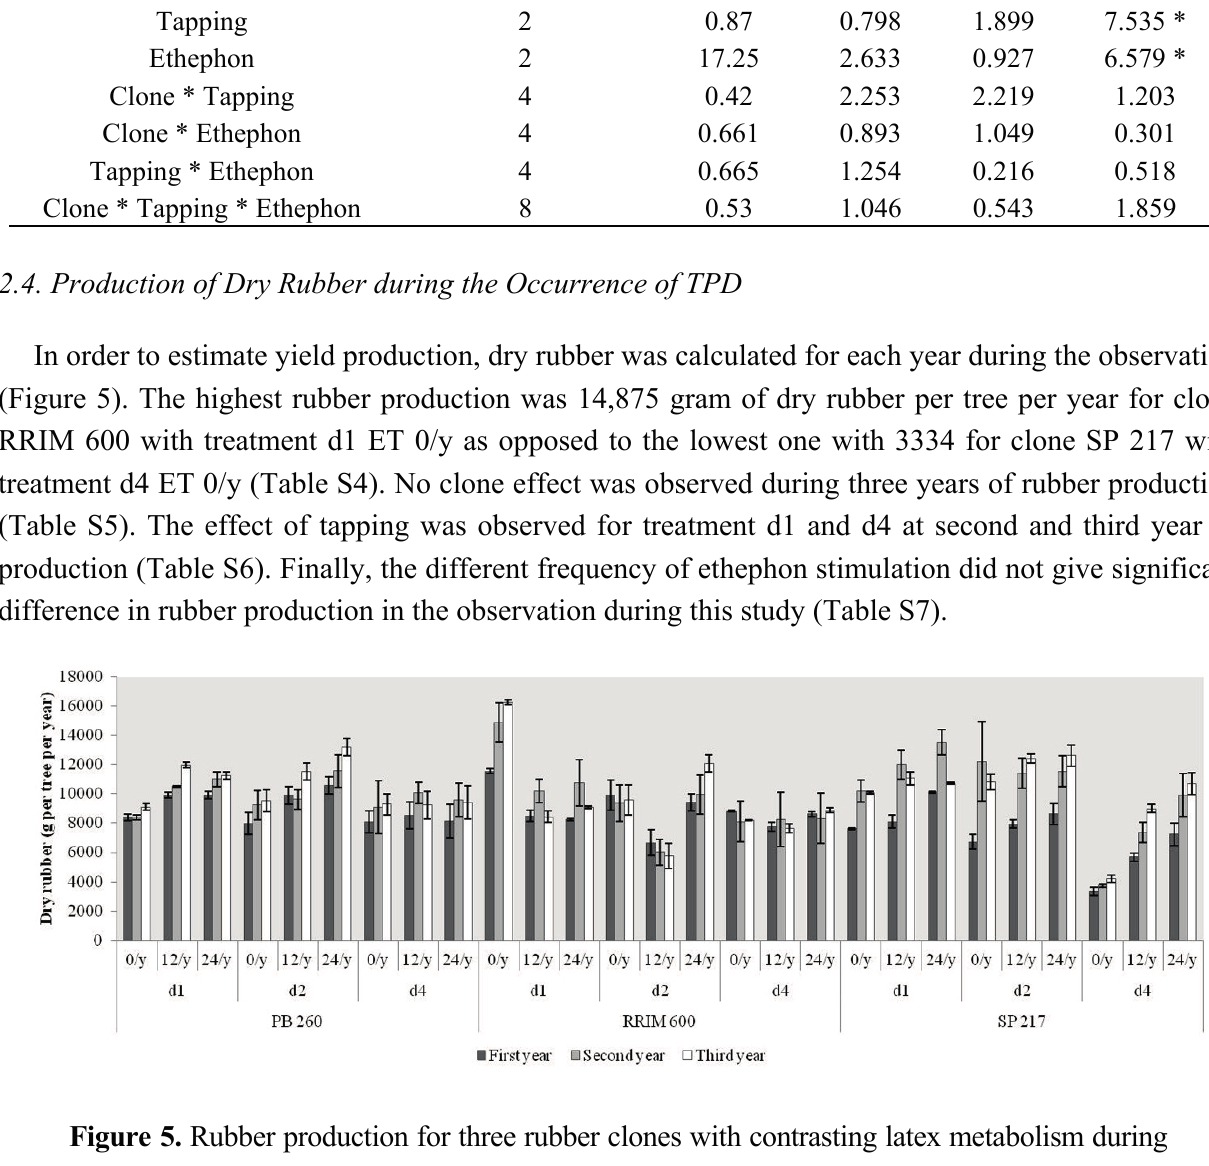
Figure 5. Rubber production for three rubber clones with contrasting latex metabolism during 2 years of observation after first tapping. Values are total mean of 12 months of production. Standard deviation (black